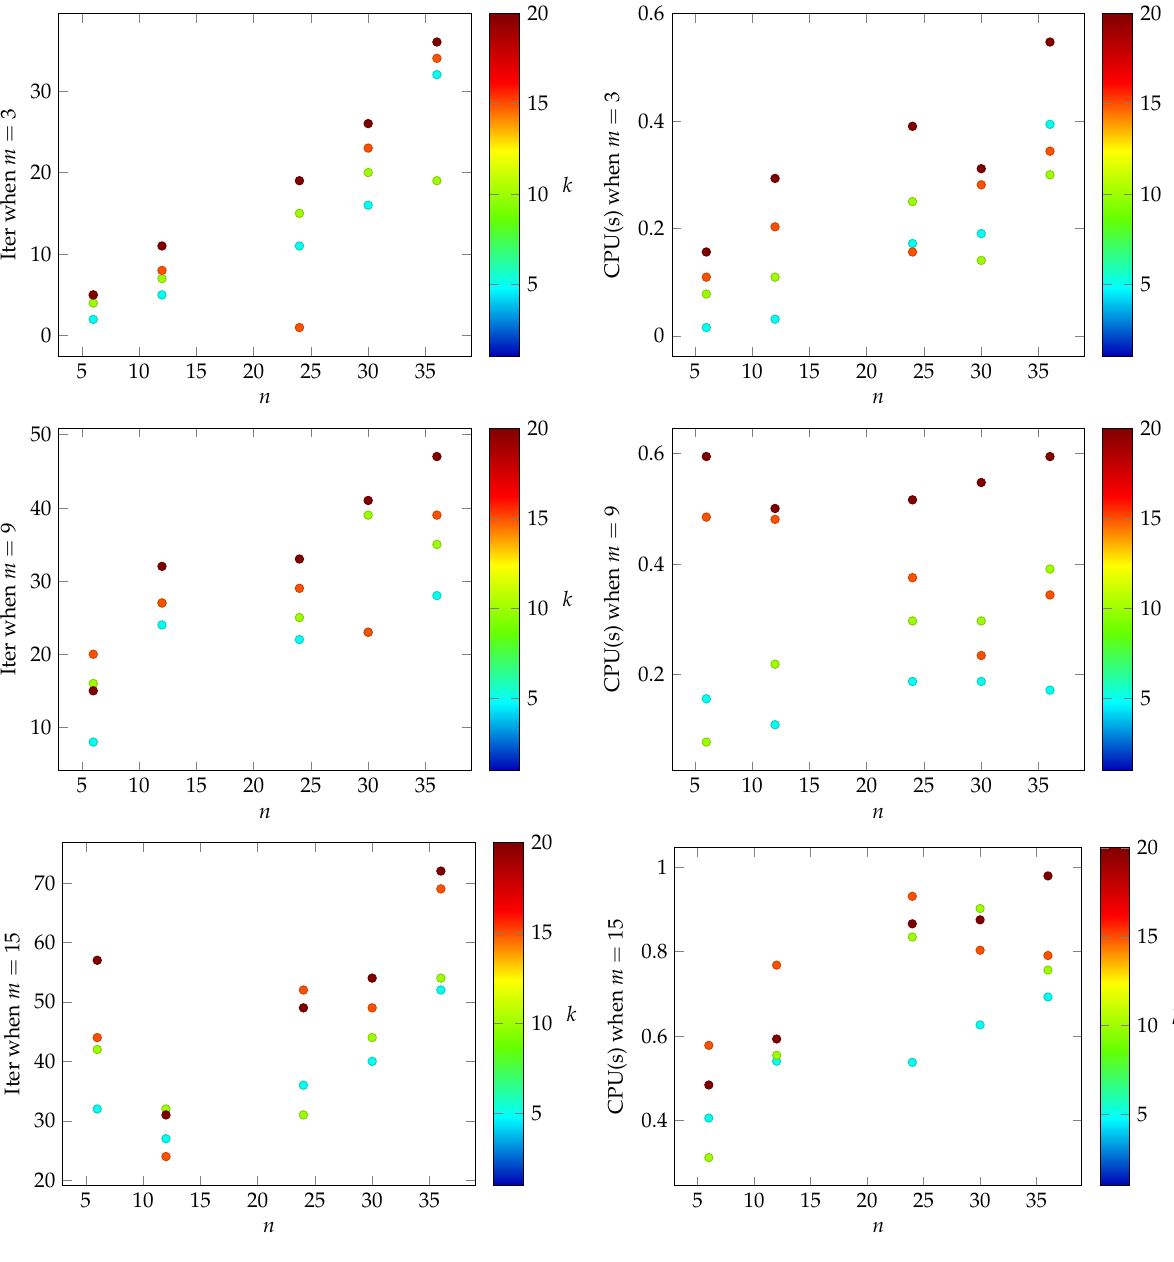
Figure 6.1. Dot plots of the numerical results obtained in Example 6.1. Figure 3. Dot plots of the numerical results obtained in Example